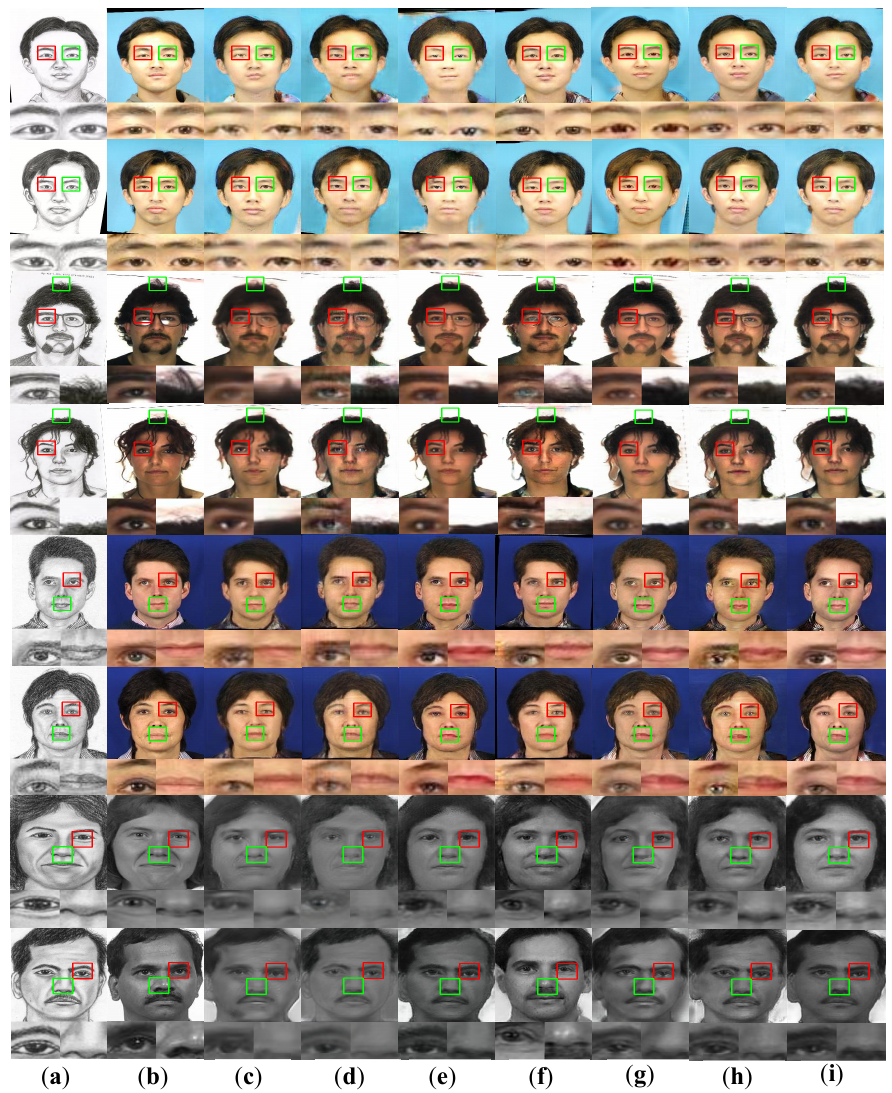
Figure 7. Comparison of synthetic results of different methods. The red and green boxes clearly show the details of the photos synthesized by different methods. ( a ) Original sketch; ( b ) Real Photo; ( c ) Pix2Pix; ( d ) CycleGAN; ( e ) PS 2 MAN; ( f ) CA-GAN; ( g ) DivCo; ( h ) MSPC; ( i ) Ours.